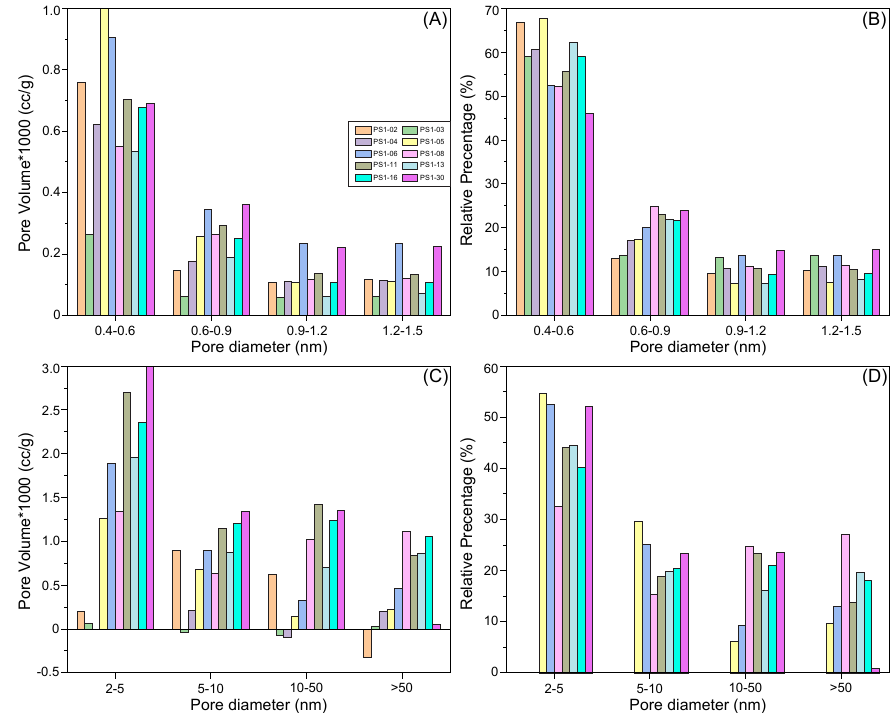
Figure 8. Pore volume and relative percentage occupied by irreducible water in ( A , B ) the micropores and ( C , D ) the non-micropores of the studied WF–LMX shales from the Well PS1. The absolute pore volumes of non-micropores occupied by irreducible water seem to be larger than those of micropores (Figure 8A,C), implying that the irreducible water is more easily stored in non-micropores than in micropores of our highly-matured shale samples. Moreover, the quartz-rich shale samples (e.g., PS1-02, PS1-03, and PS1-04) have relatively low absolute pore volumes occupied by irreducible water (Figure 8C), which display negative values in pore diameters greater than 5 nm. This abnormal phenomenon may result from subtle analytical errors in the N 2 adsorption experiments since the irre- ducible water content of our studied shale is very low and the volume difference of non- micropore between as-received and dry shale samples is very small. A similar phenome- non can also be observed in previous works (e.g., [22]). Excluding these outliers, the ab- solute pore volumes occupied by irreducible water and its relative percentage also de- crease with increasing pore diameter (Figure 8C,D). The irreducible water mainly occurs in smaller mesopores, with a pore diameter of 2–5 nm and 5–10 nm, and the average rel- ative percentages are 45.8% and 21.8%, respectively (Figure 8D). However, relative per- centages of the irreducible water in the pore diameter range of 10–50 nm and >50 nm are 17.7% and 14.6%, respectively (Figure 8D), indicating that the irreducible water may be rarely distributed in the larger mesopores and macropores of shale. In a word, irreducible water is primarily distributed in non-micropores rather than in micropores of the highly- matured shale, and it is mainly distributed in micopores with a diameter of 0.4–0.6 nm and mesopores with a diameter of 2–10 nm.